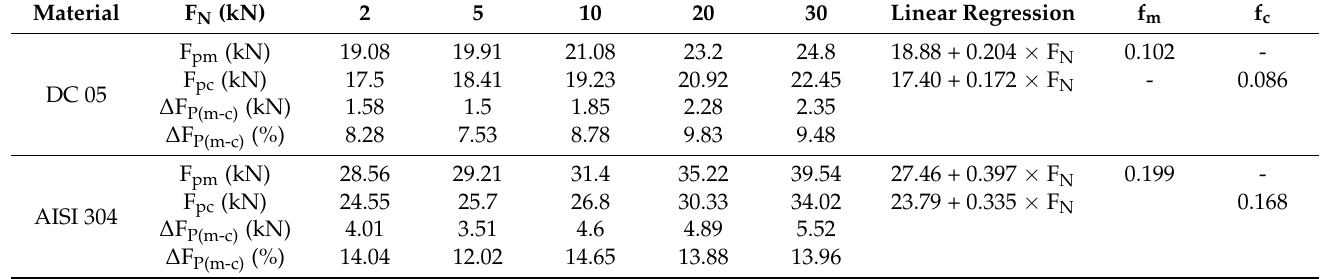
Table 5. Comparison of experimentally measured F pm and calculated F pc values for drawing forces. Material